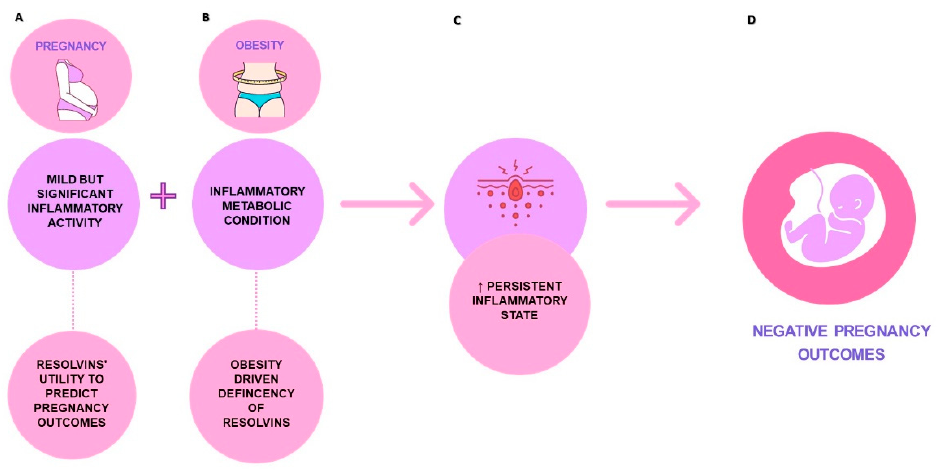
Figure 2. Pregnancy and obesity involvement in inflammatory state and resolvins’ correlation: ( A ) mild but significant inflammatory activity in physiological pregnancy where resolvins could be useful biomarkers for pregnancy and neonatal outcomes ( B ) in pregnancies complicated by obesity the probability of a persistent inflammatory state increases also due to the resolvins’ deficiency, ( C ) consequences are a persistent inflammatory state and multiple repercussions that add up to the complications associated with acute inflammation and ( D ) subsequent negative pregnancy out- comes.